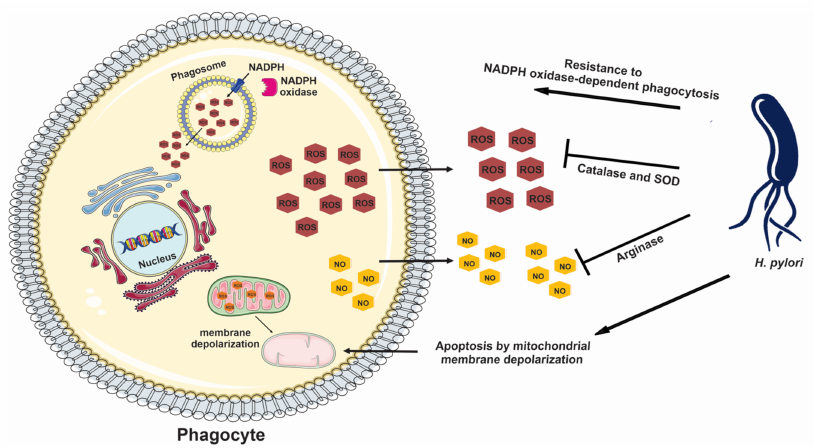
Figure 1. H. pylori survival strategies against phagocytes. The bacterium secretes catalase and SOD to reduce ROS toxicity, synthetizes arginase to limit NO production, reduces host NADPH oxidase response, and induces macrophage